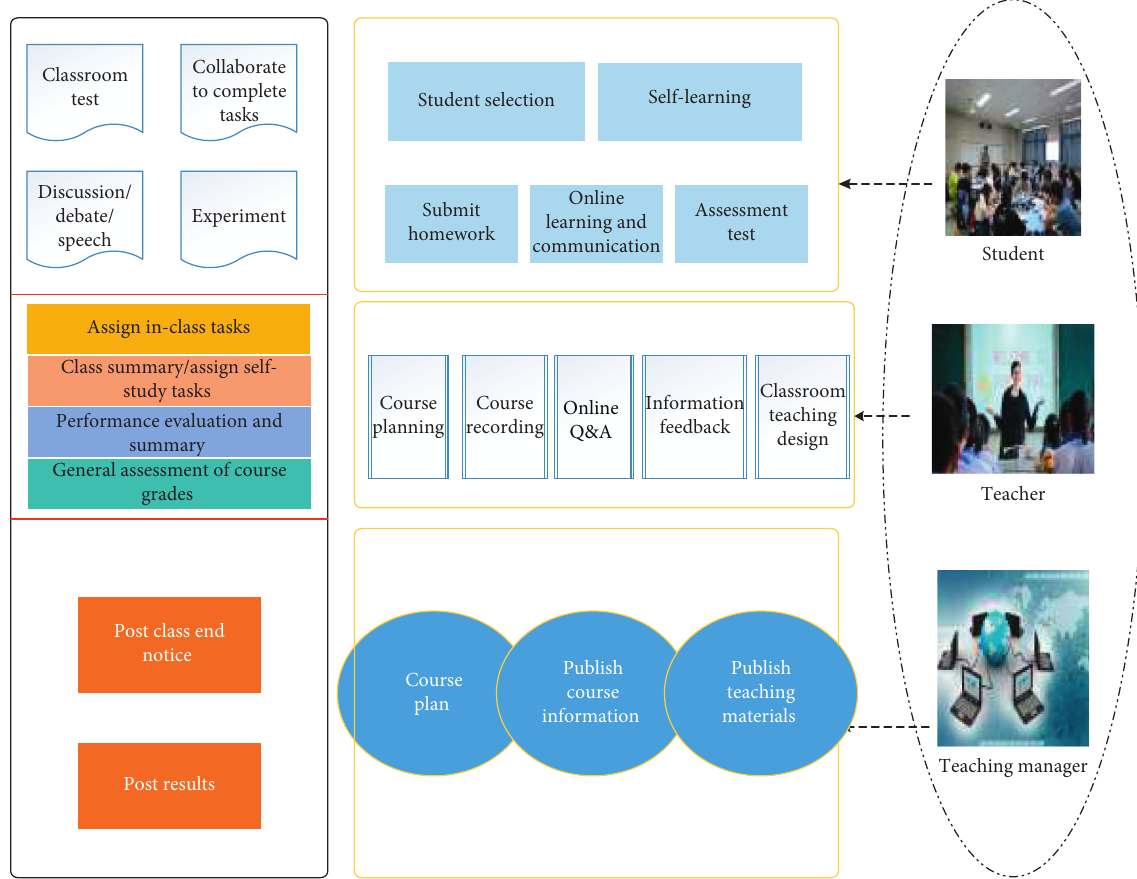
Figure 2: Flipped classroom model based on open online